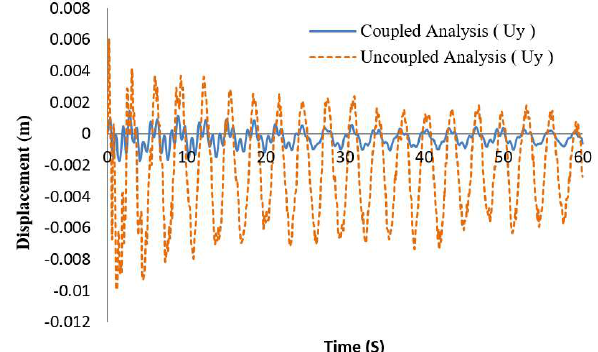
Figure 11. Comparison of displacements in the x-direction resulted from coupled and uncoupled analyses from the X-SEA program.